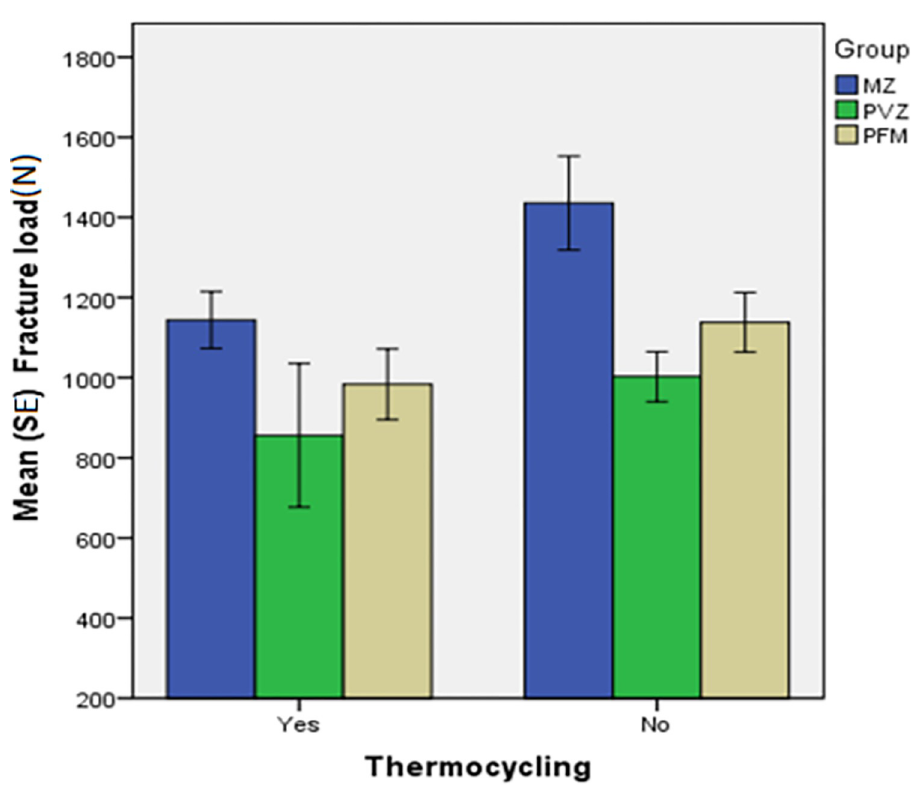
Fig 7. The mean and standard error (SE) of fracture load in the study groups.